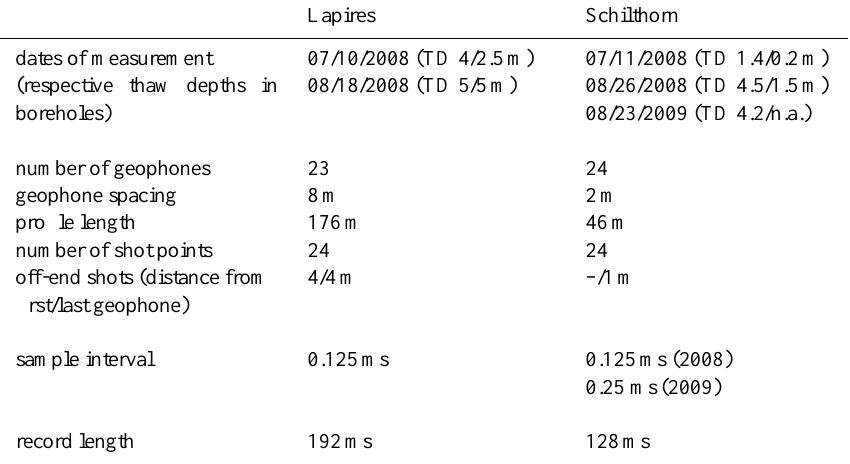
Table 1. Measurement details for the time-lapse refraction seismic test sites (abbreviations: TD=thaw depth, n.a.=notavailable). Lapires Schilthorn dates of measurement (respective thaw depths in